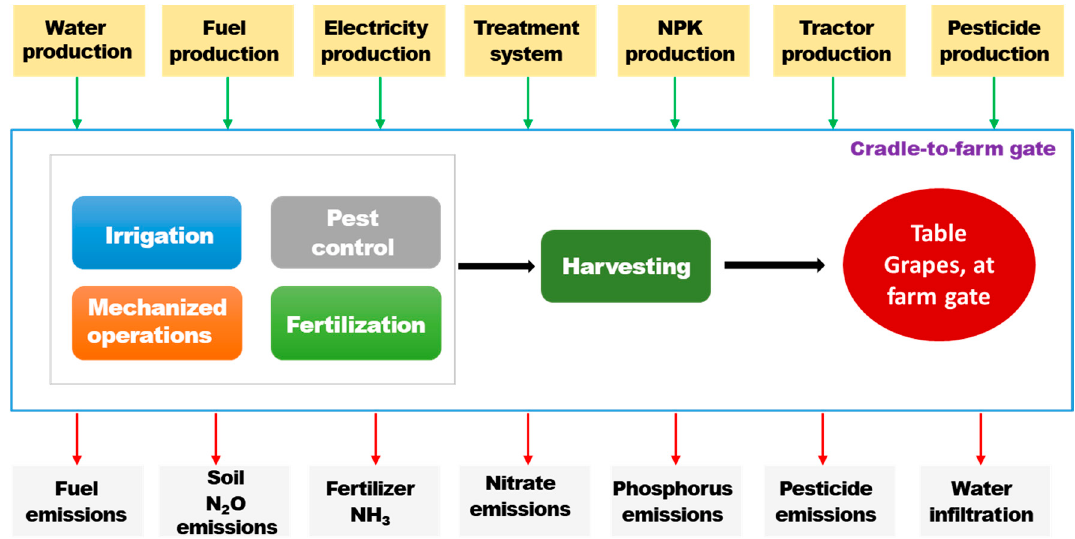
Figure 4. System boundary for life cycle performance of grape production systems.